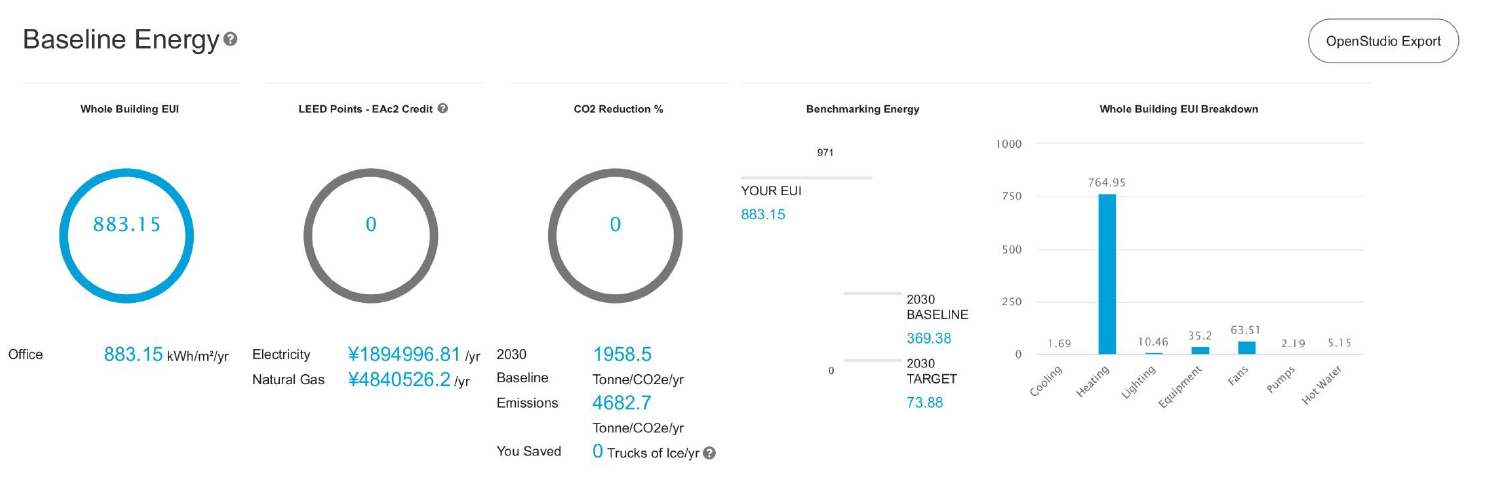
Figure A42. Zone 7 Harbin, Heilongjiang (post-COVID-19 84% scenario).